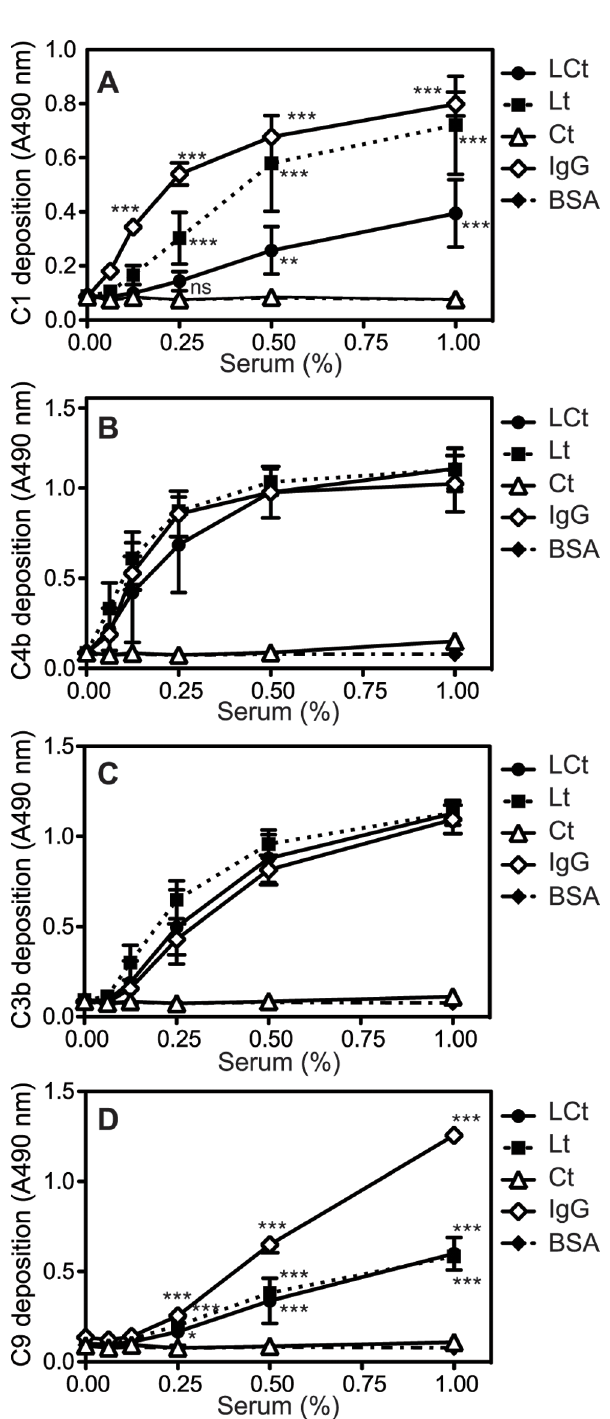
Figure 2. Lectin domain of aggrecan G3 module activates the classical pathway. Aggregated IgG (positive control for classical pathway), LCt, Lt, Ct and BSA (negative control) were coated onto microtiter plates and increasing concentrations of normal human serum (NHS) were added. Activation of the classical pathway was measured by detecting deposited C1q ( A ), C4b ( B ), C3b ( C ) and C9 ( D ). The graphs show the mean and standard deviation (SD) of three independent experiments. Statistical significance of differences was calculated using a two-way ANOVA with a Bonferroni posttest. * p , 0.05, **p , 0.01, ***p , 0.001.).